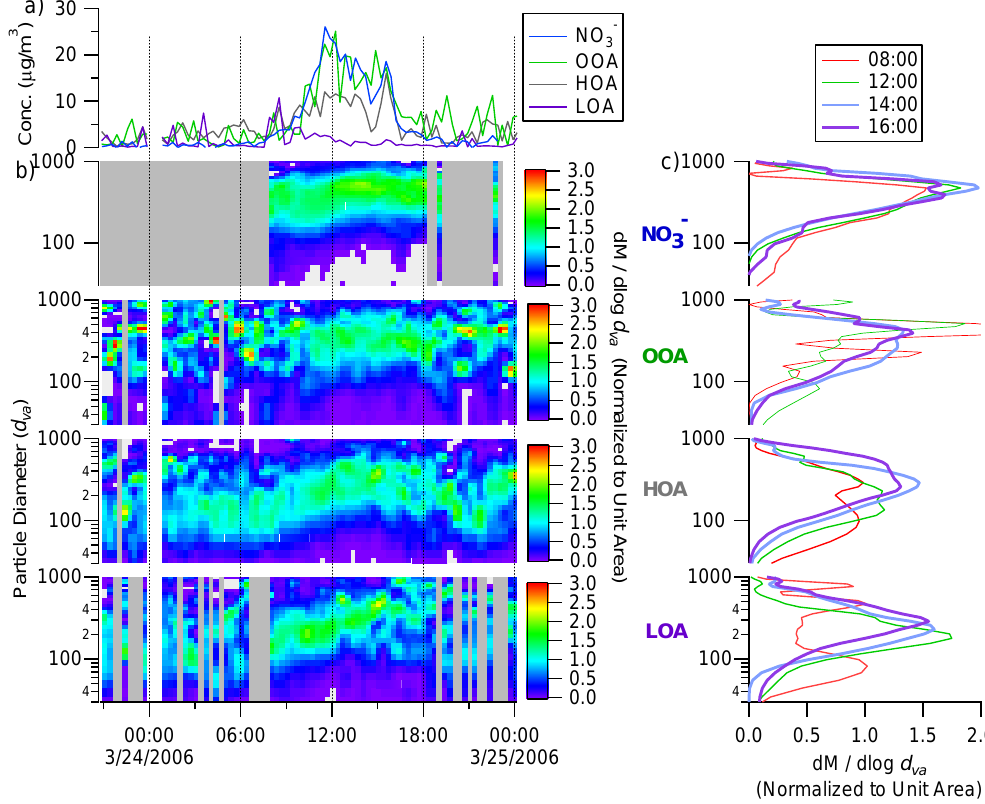
Fig. 8. Case study event on 24 March 2006. (a) Time series (LT) of mass concentrations of OOA, HOA, and LOA in the best solution of the vector-matrix model and NO − . (b) Mass size distributions (d M /dlog d va ) of OOA, HOA, and LOA and NO − 3 distribution has unit area. The factor size distributions have been binomially smoothed by one point each in time and size for improved visual clarity. Light-grey pixels have zero signal. Medium grey bars indicate time steps with integrated species concentration less than 0.3µgm − 3 for organics and 1.5µgm − 3 for nitrate. (c) Size distributions from selected hours (LT), normalized to unit area to compare the shapes of the